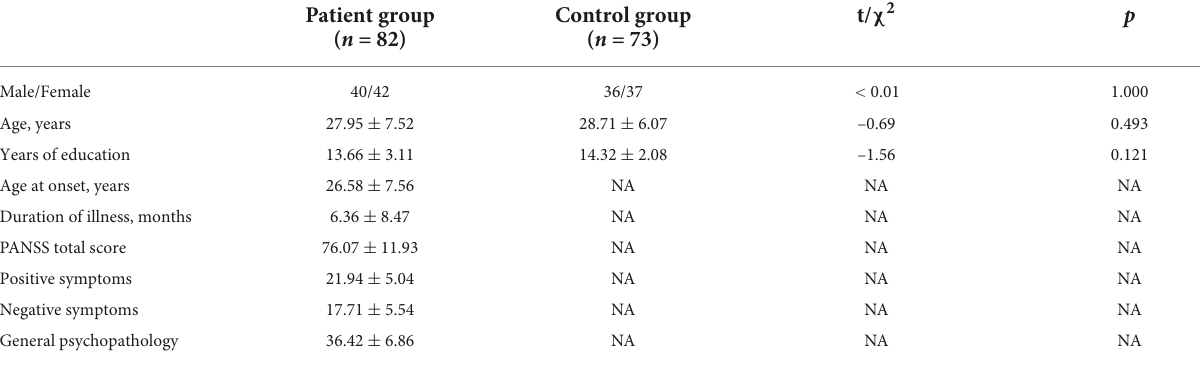
TABLE 1 Demographic and clinical characteristics of samples.